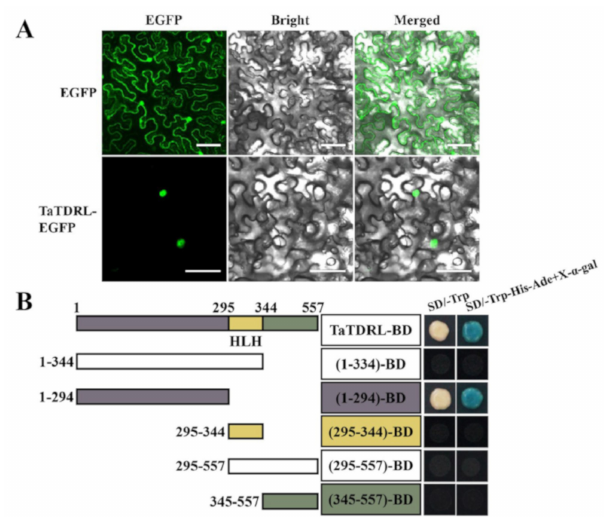
Figure 5. Nuclear-localized TaTDRL has transcriptional activation activity in yeast cells. ( A ) Subcellular localization of TaTDRL-enhance green fluorescence protein (EGFP) fusion protein in tobacco epidermal cells. Scale bars = 50 µ m. ( B ) Transactivation assay of the TaTDRL proteins. Full-length and di ff erent portions of TaTDRL were fused with the GAL4 DNA-binding domain and then expressed in yeast strain Y2H. The transformed yeast cells were plated and grown on control plates (SD / -Trp) or selective plates (SD / -Trp-His-Ade + X- α